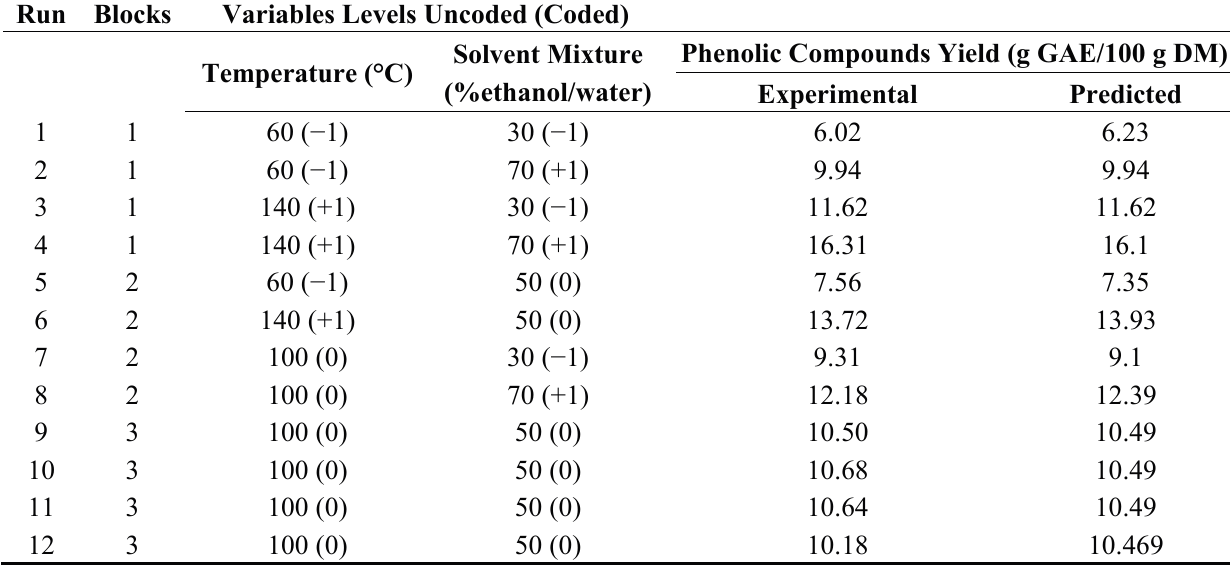
Table 1. Arrangement for independent variables and their responses for ASE